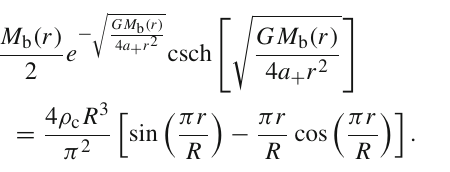
and dark matter